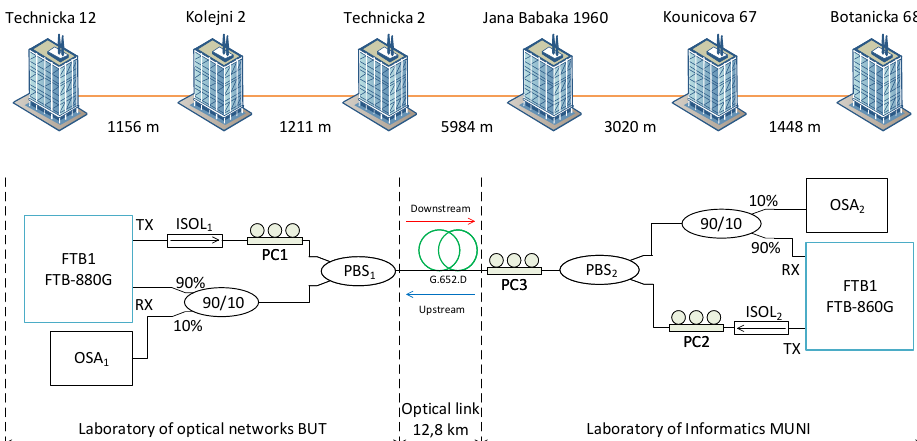
Figure 6. Measurement on a real optical link The output signal from the SFP+ module went through an optical insulator ISOL 1 (to avoid damage caused by back reflection) to a polarization controller PBS 1 , where the angle of polarization was optimally rotated so that the optical signal of the output of PBS1 was at the maximum level (as measured by the OSA), which was then disconnected, and PBS1 was connected to a real optical link. The opposite transmission and receiver side was realized by the Faculty of Informatics at Masaryk University, Brno. The output signal from the optical link was controlled by PC3 to obtain the maximum power level of the output signal. This signal was monitored by an optical spectrum analyzer OSA 2 . As a transmitter on the opposite side, an EXFO FTB-1 platform with an EXFO Net- Blazer 860G module and a 10 Gbps SFP+ module (Optoway SPS-2385MW-D440G) was also used. The 860G module has similar functionalities to those of 880G. The transmitted 10 Gbps signal went through ISOL 2 to polarization controller PC2, which was used to set the maximum optical level of an output of PBS 2 (monitored by the OSA). The optical links consisted of many connector connections in each building. It is obvious that optical links are very prone to changes in polarization due to temperature